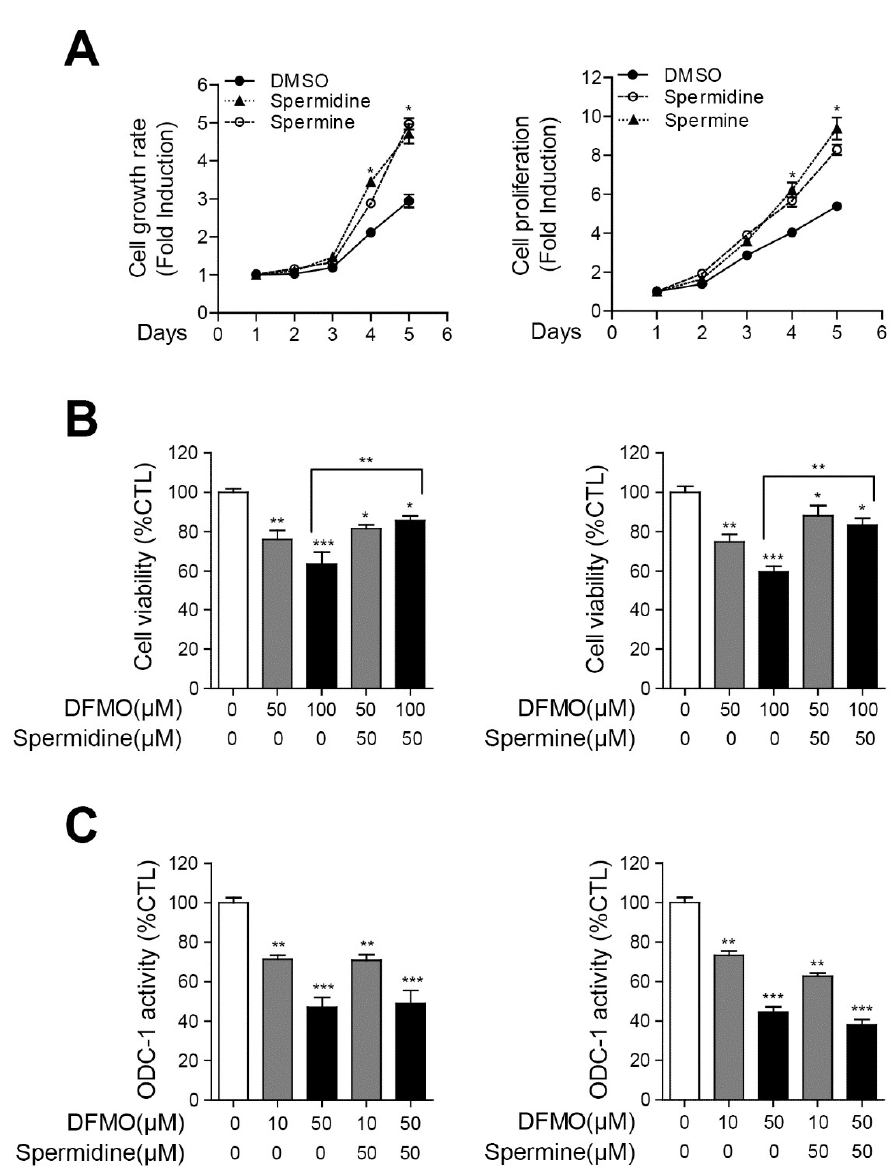
Figure 2. Interruption in DFMO-induced cell death by polyamines in SKOV-3 cells. ( A ) SKOV-3 cells were incubated with polyamines for 1–5 days. Cell growth rate and proliferation were deter- mined using the PrestoBlue and CellTiter-Glo assays, respectively. ( B ) Polyamines were treated with a concentration of 0 or 50 µM for 48 h in DFMO-treated SKOV-3 cells, and the cell viability in DFMO/polyamines-treated SKOV-3 cells was measured using the PrestoBlue assay. ( C ) ODC-1 ac- tivity in DFMO/polyamines-treated SKOV-3 cells was detected using the Luciferase Assay (Lucifer- ase Assay System). The controls were treated with 0.1% DMSO. Data are expressed as mean ± SD. * p < 0.05, ** p < 0.01, *** p < 0.001 compared with the controls. 2.3. Combination of DFMO and Cisplatin Therapy Reduces Cancer Cell Survival and Promotes Apoptotic Cell Death in Ovarian Cancer Cells To confirm the hypothesis that the addition of DFMO to a platinum-based anti-cancer drug would reduce cancer cell survival and induce apoptotic cell death in ovarian cancer cells, SKOV-3 cells were co-treated with 0–100 µM DFMO and 10 µM cisplatin for 48 h.